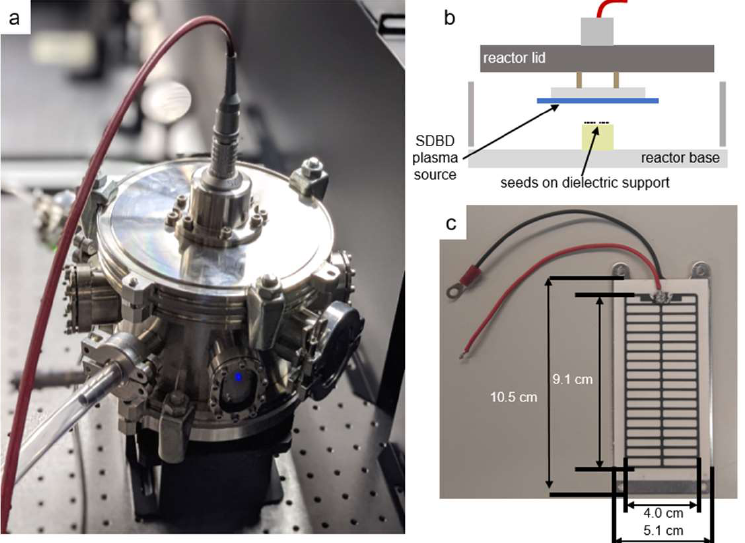
Figure 10. Surface dielectric barrier discharge (SDBD) plasma source enclosed in the plasma-seed treatment reactor. ( a ) Stainless steel reactor with high-voltage coaxial cable connection; ( b ) schematic of the interior with the inverted SDBD positioned above the seed substrate; ( c ) photograph of the high-voltage stripe SDBD electrode printed on an alumina dielectric plate. The ground electrode is an aluminum plate behind the dielectric.